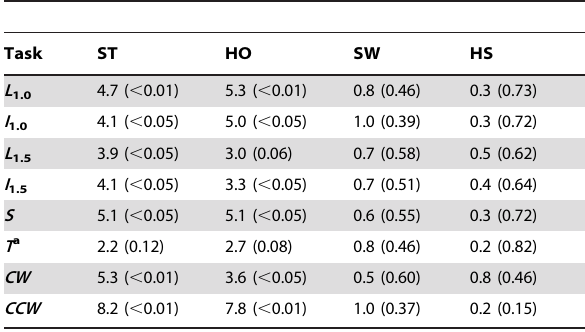
Table 2. p values from ANOVA on time spent in gait phases depending on health